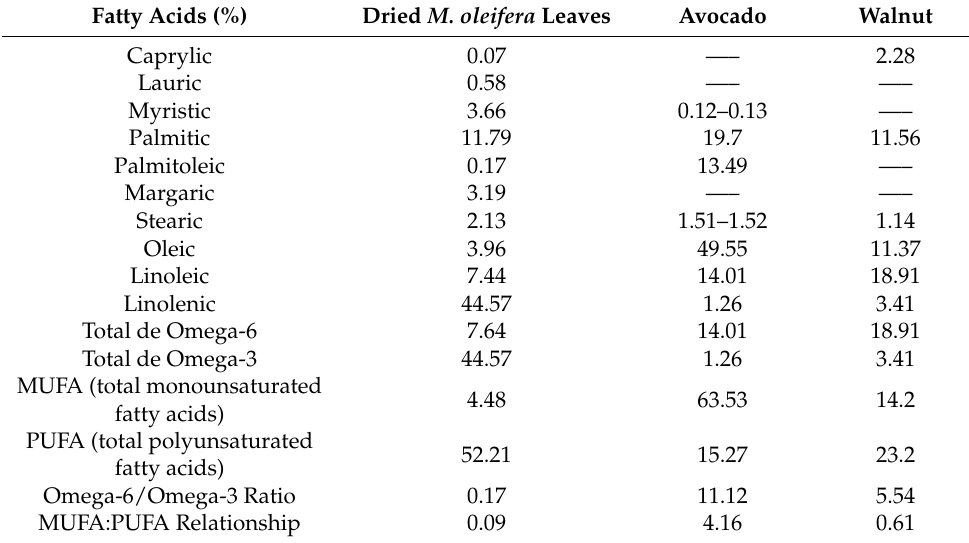
Table 4. Composition of fatty acids in the dried leaf of M. oleifera (Sources: [59,65,66]). Fatty Acids (%) Dried M. oleifera Leaves Avocado Walnut Caprylic